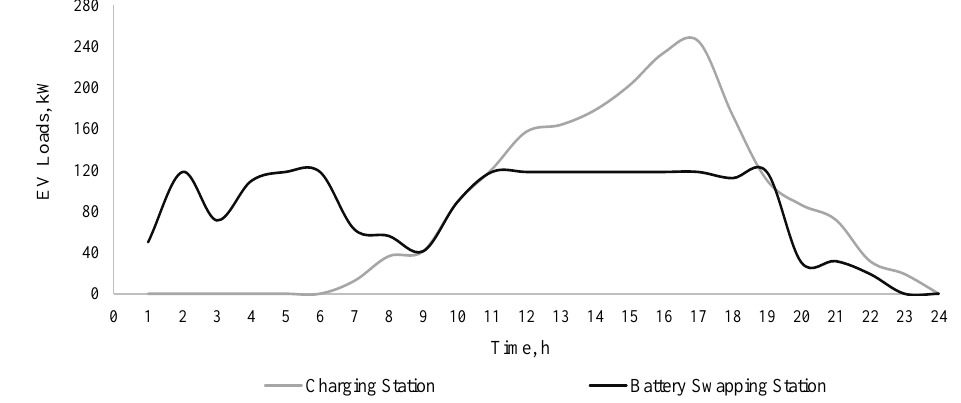
Figure 6. EV load profiles of the charging and battery-swapping stations.